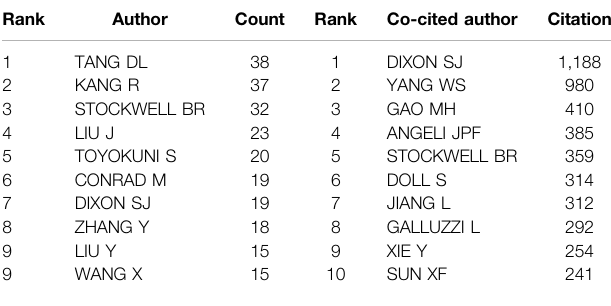
TABLE 4 | Top 10 productive authors and co-cited authors related to ferroptosis in cancer